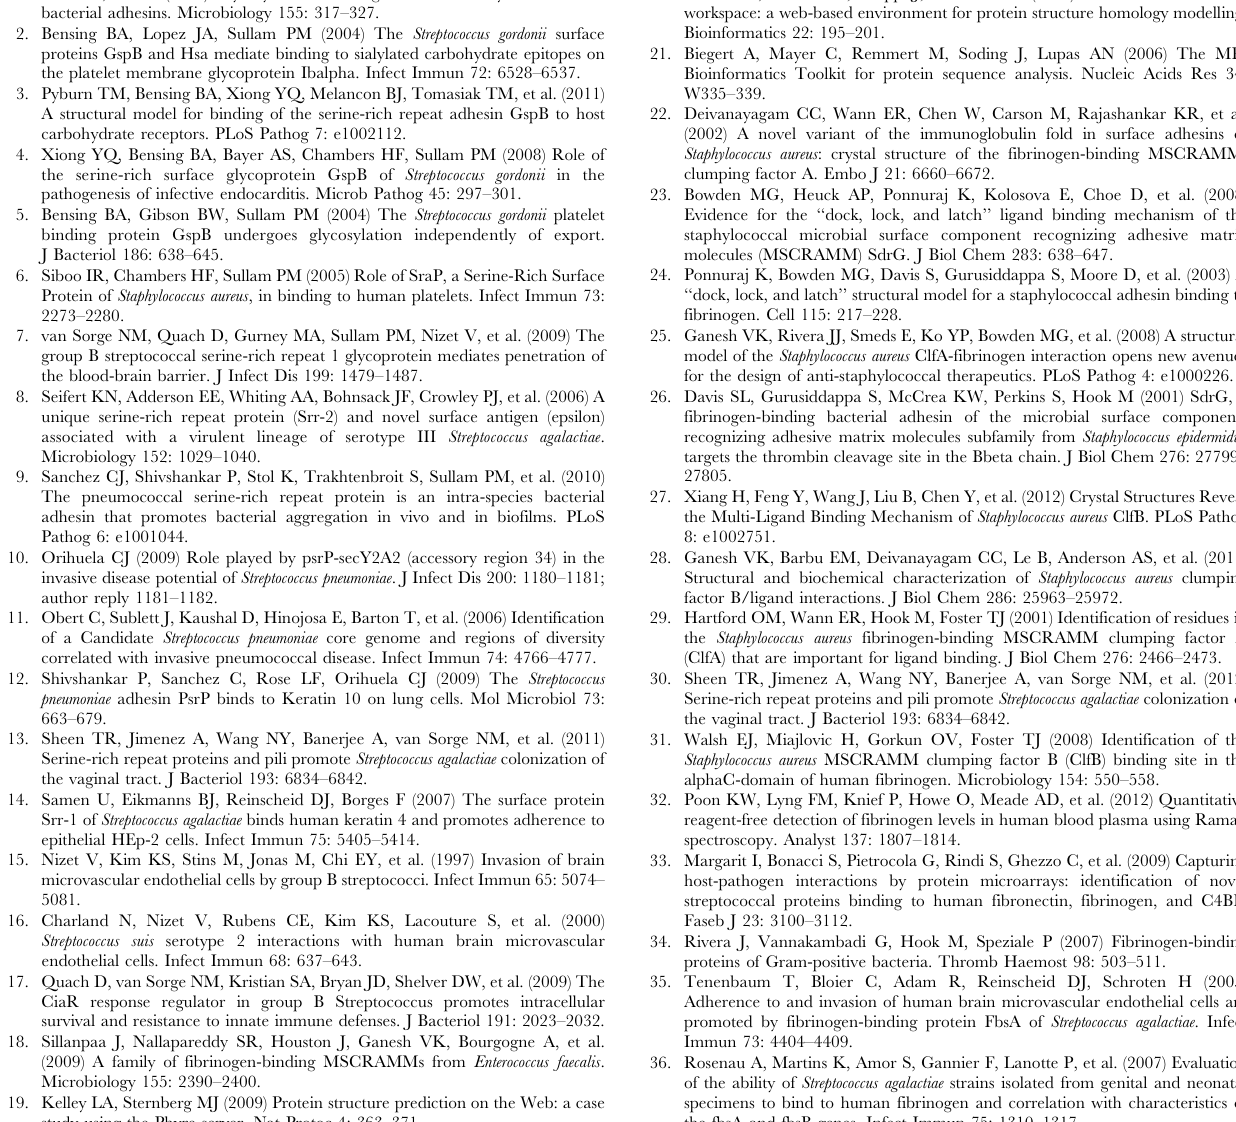
Table S3 Latching cleft and latch domains within the binding regions of fibrinogen binding